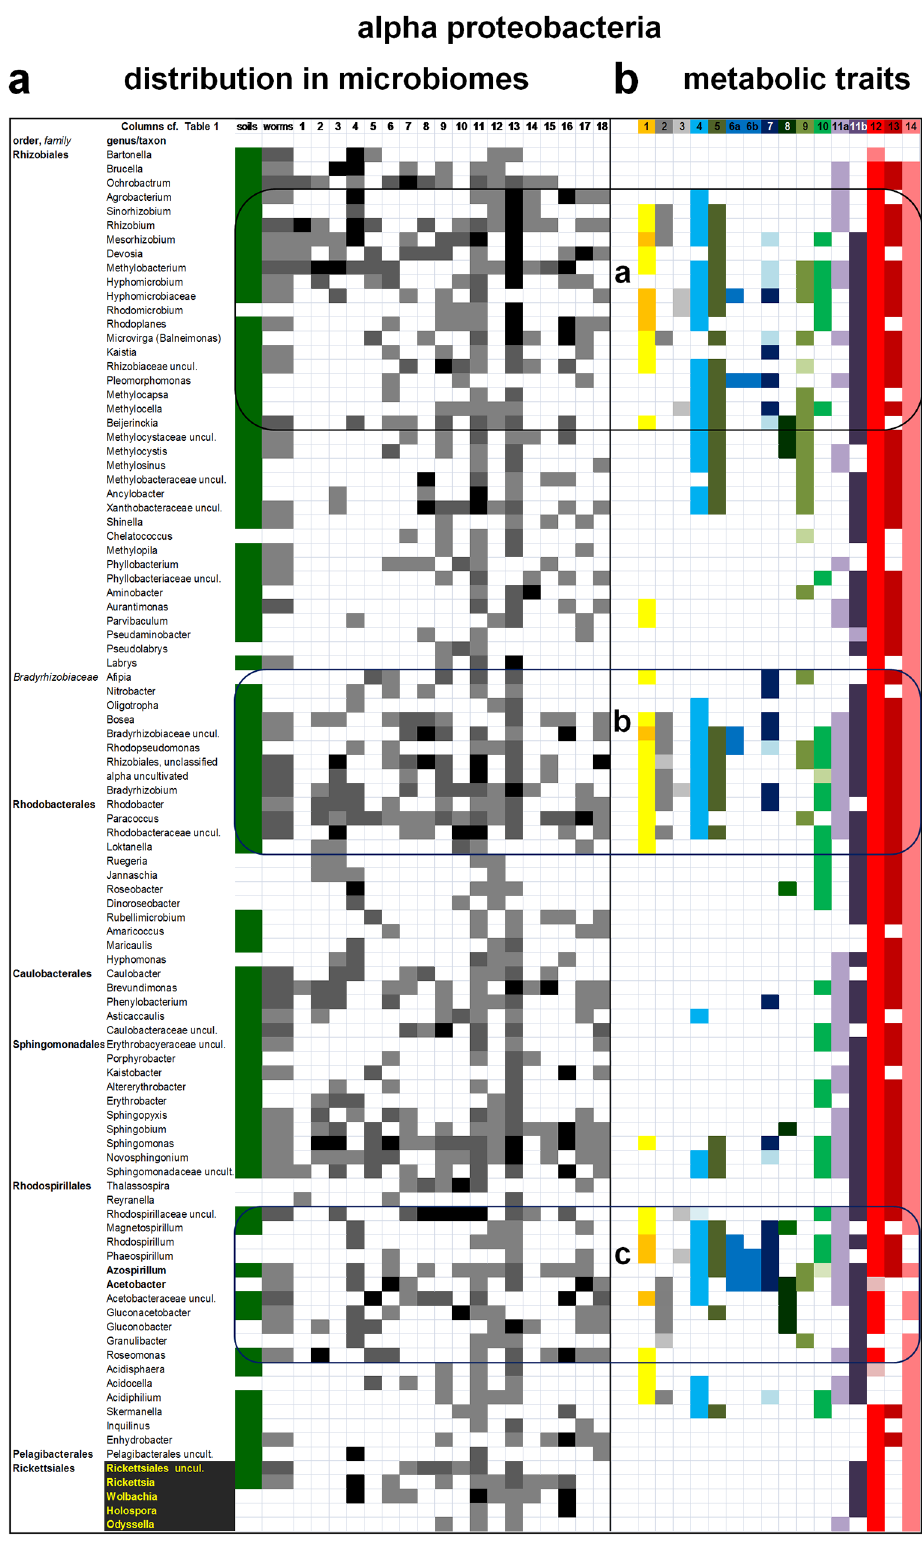
Fig 1. Visualization of the taxonomic distribution and metabolic traits of alpha proteobacteria in the microbiome of soils, C . elegans and 18 arthropods. Taxa of alpha proteobacteria found in the microbiome